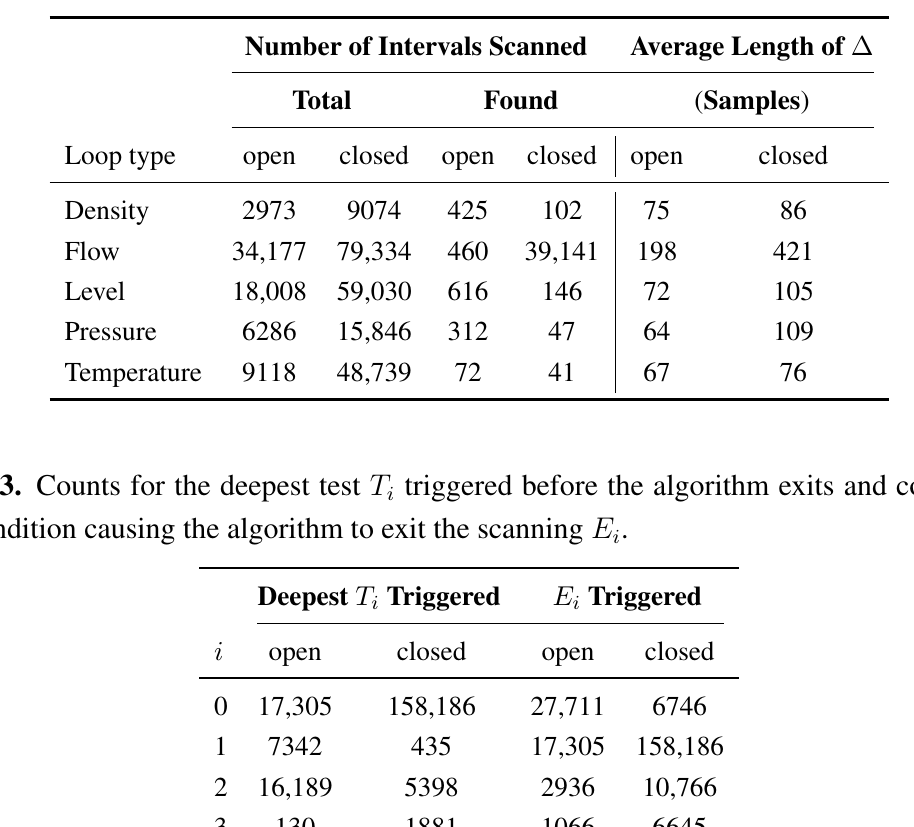
Table 2. Some statistics characterizing the performance of the method when applied to a historical dataset.